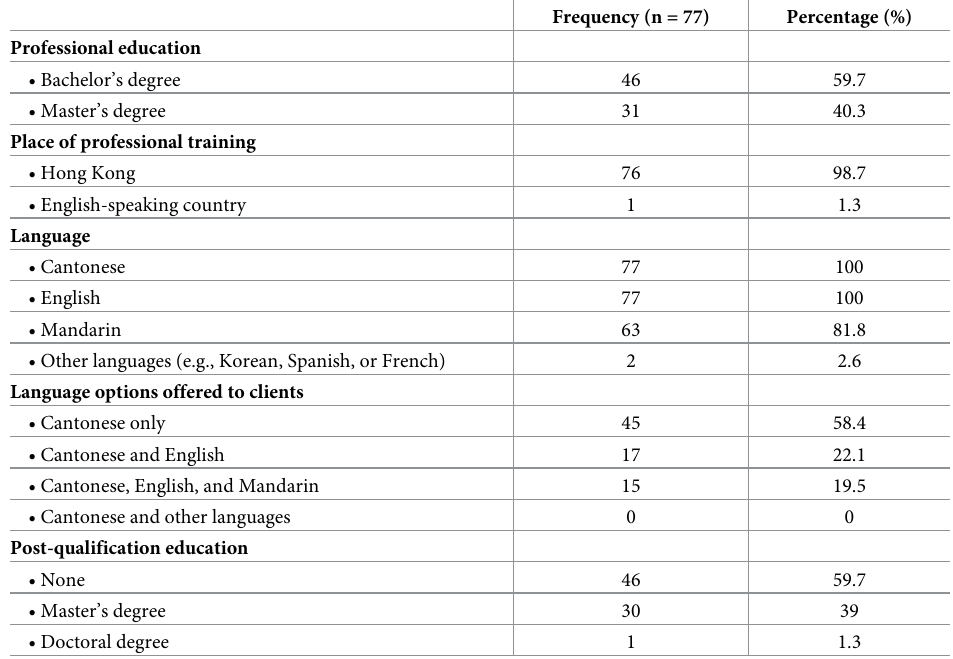
Table 1. Demography of